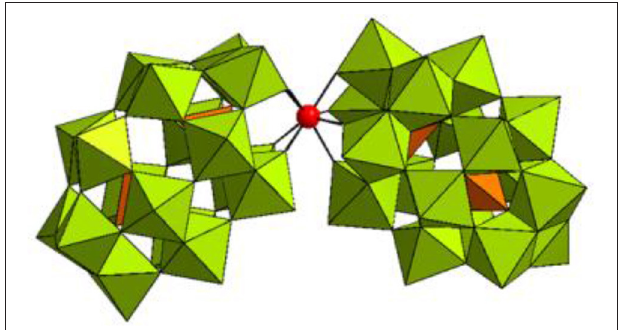
FIGURE 1 | Combined polyhedral/ball-and-stick representation of [Hf( α 2 -P 2 W 17 O 61 ) 2 ] 16 − in K 16 [Hf( α 2 -P 2 W 17 O 61 ) 2 ] · 19H 2 O. WO 6 octahedrons are shown in olive green, PO 4 tetrahedrons are shown in orange, and the Hf(IV) center is represented as a red